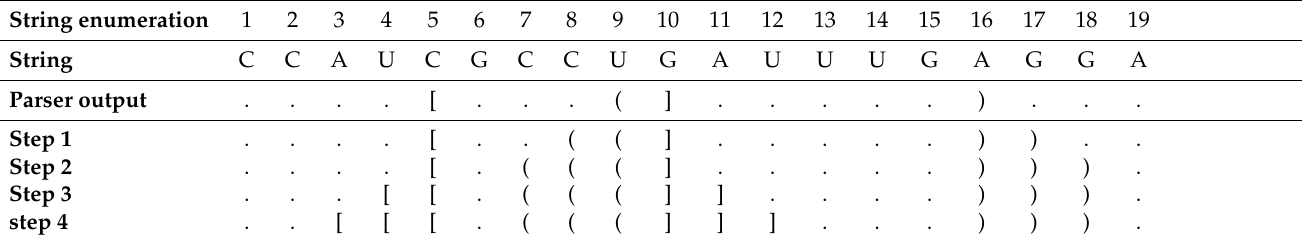
Table 2. Decoration of core stems of